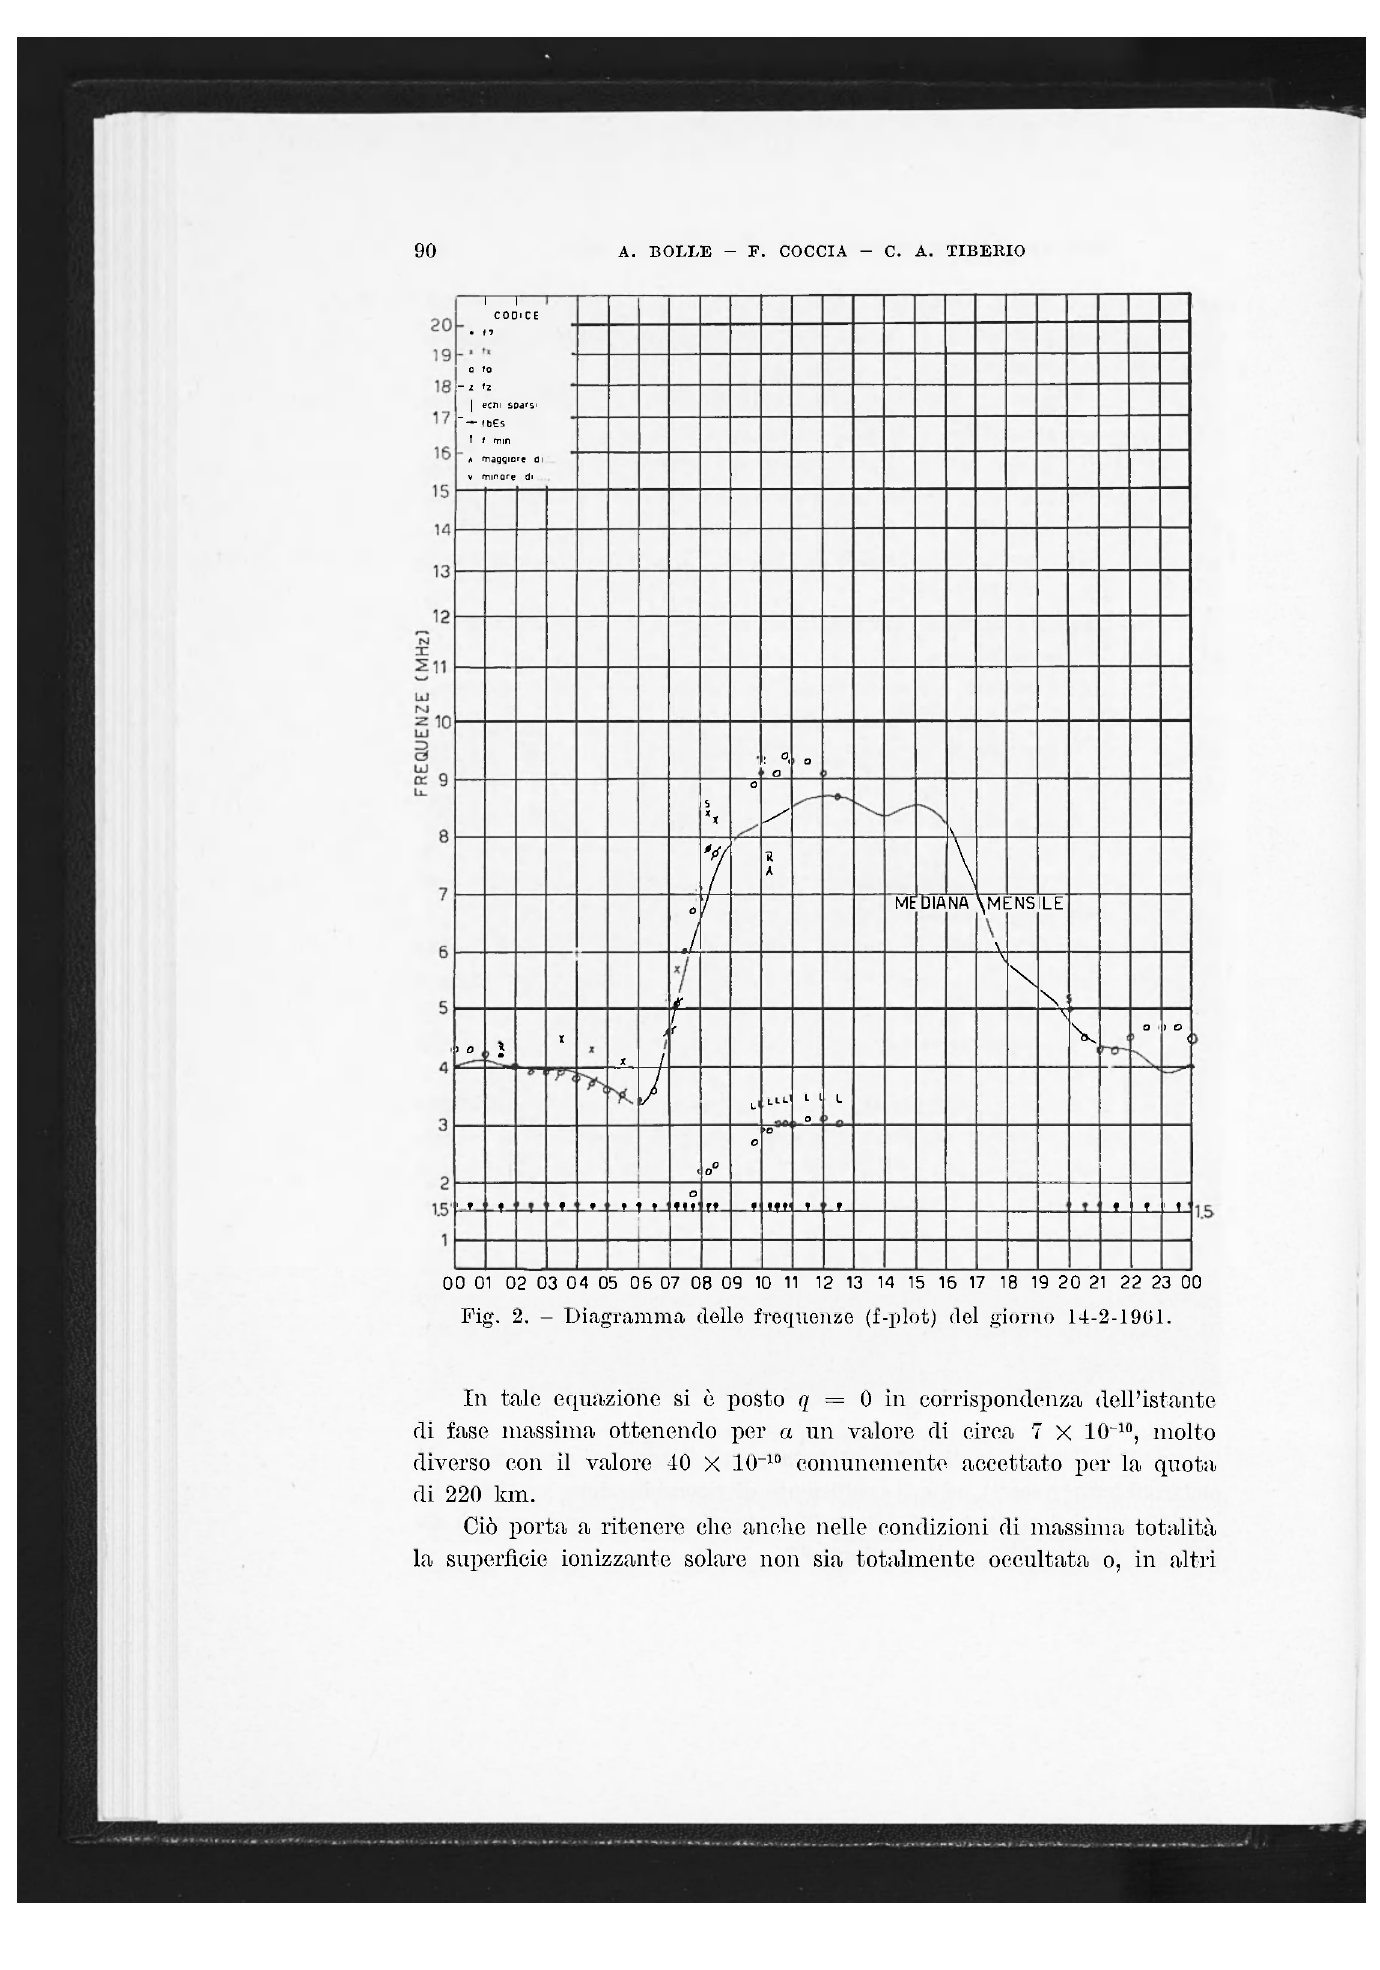
In tale equazione si è posto <7 = 0 in corrispondenza dell'istante di fase massima ottenendo per a un valore di circa 7 X 10~ 10 , molto diverso con il valore 40 X IO -10 comunemente accettato per la quota di 220